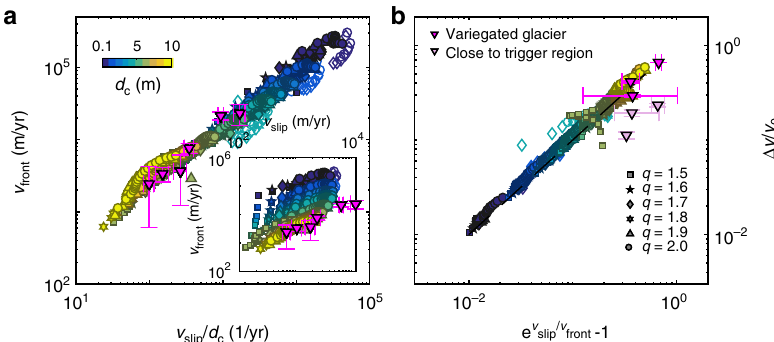
Fig. 6 Scaling relations for the propagation velocity, the sliding velocity and the surface elevation change. a Dependence of surge front velocity v front on sliding velocity v slip ∀ x ∈ [5, 15] km. The scaling relation v front ~ v slip / d c applies for simulations as well as observational data from the Variegated glacier (with d c = 7 m). b Relative elevation change as a function of e v slip = v front (cid:2) 1 ∀ x ∈ [7.5, 15] km, where elevation change Δ y is measured 250 m behind the surge front. The dashed line shows the exact relation. The fi gure also includes data from the Variegated glacier (Supplementary Figures 3 and 4), where we have used a different color on the points close to the trigger region where we do not expect the relation to be accurate. Open symbols show results using a full hydrology model (parameter set 2 in Supplementary Table 1), while closed symbols show results from the simpli fi ed model (parameter set 1